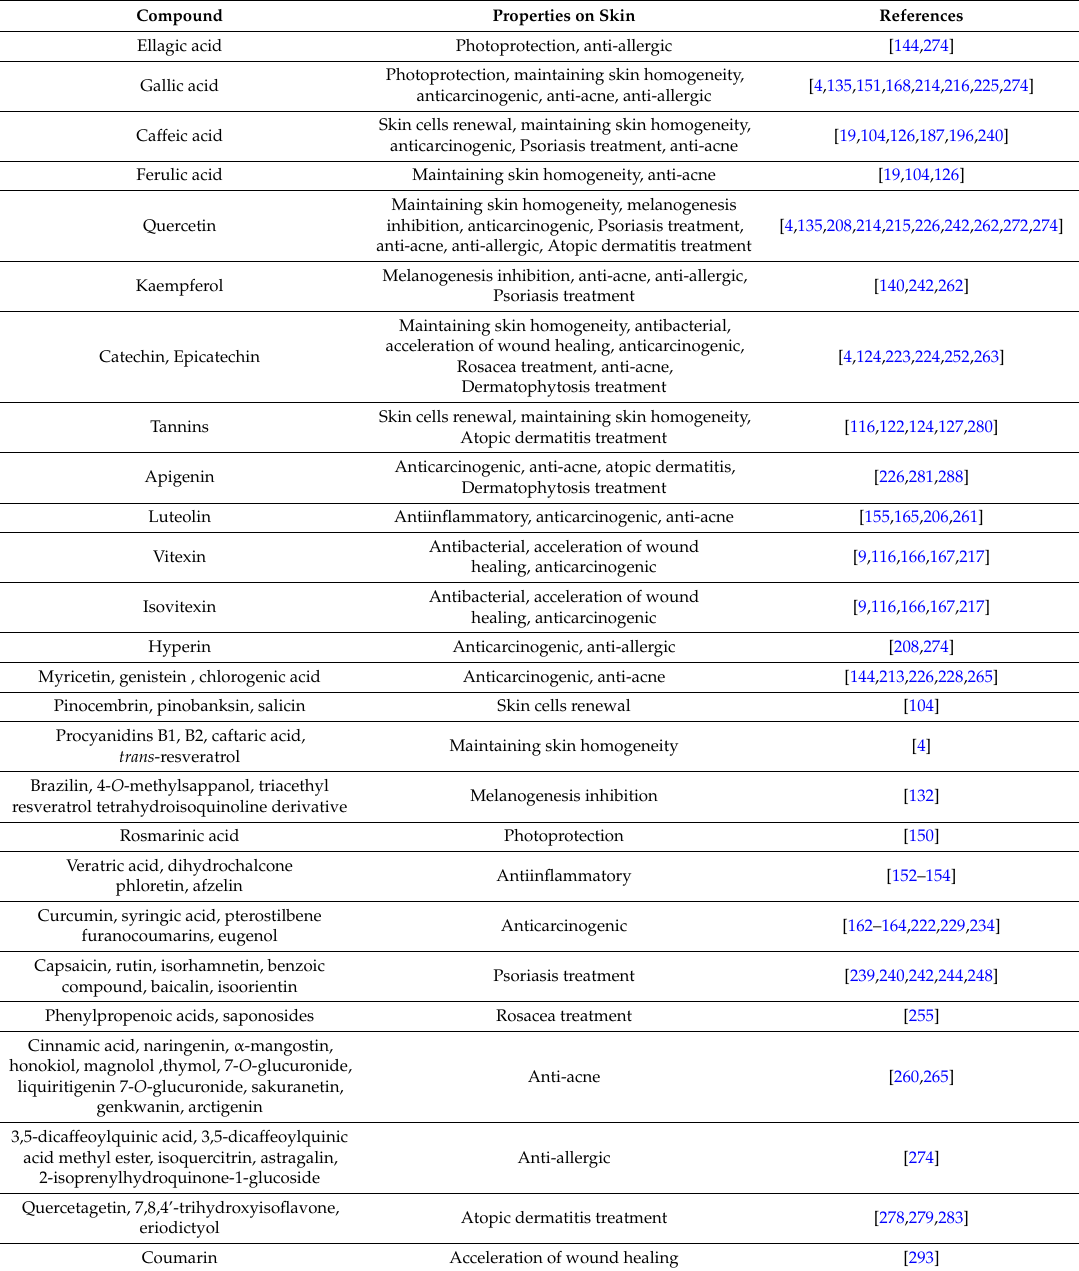
Table 4. The examples of phenolic compounds that possess protective and therapeutic activity in the treatment of skin disorders. The table is based on data in the